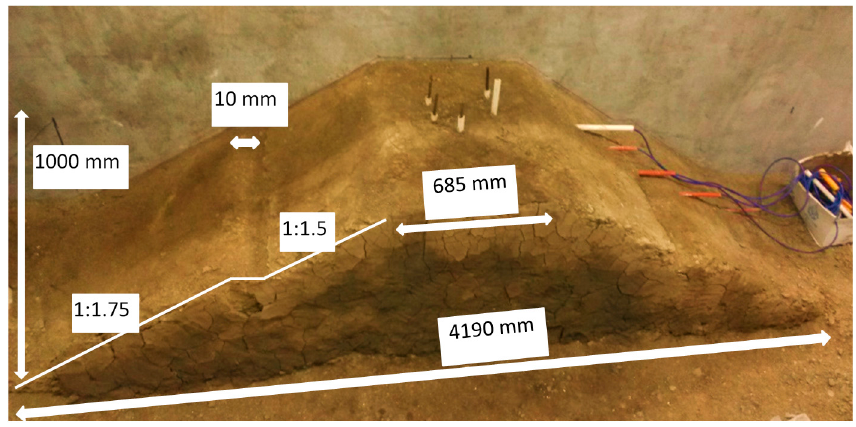
Figure 2. Profile photo of subgrade model (unit: mm).